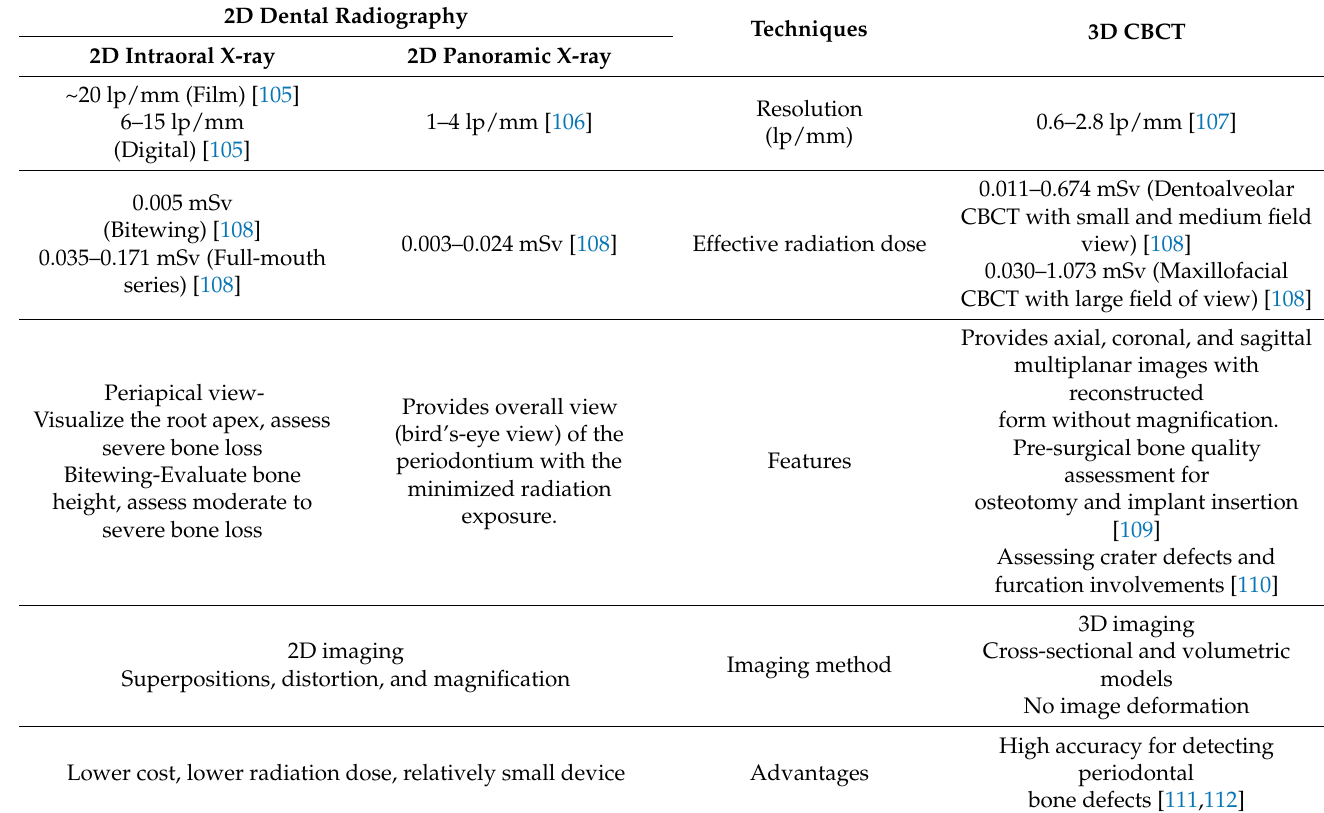
Table 1. Comparison between 2D dental radiography and CBCT. 2D Dental